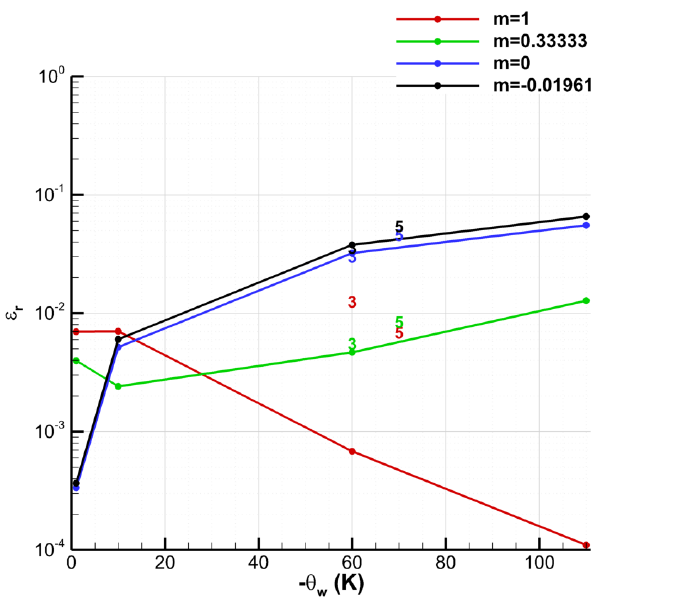
Figure 12. L 2 relative error in the wall heat flux in test-case 2 with respect to the wall temperature. The results of test cases 3, 4 and 5 are super-imposed. N x = 256, N =